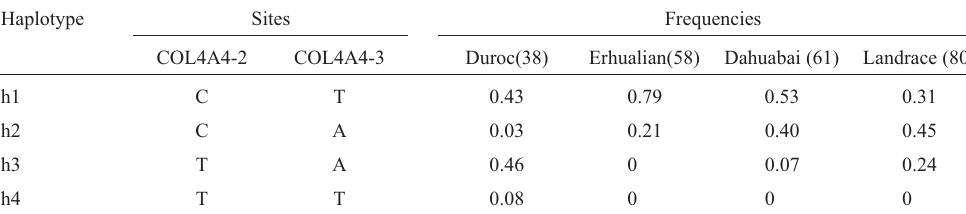
Table 3 - Base constitutions of COL4A4 haplotypes and their